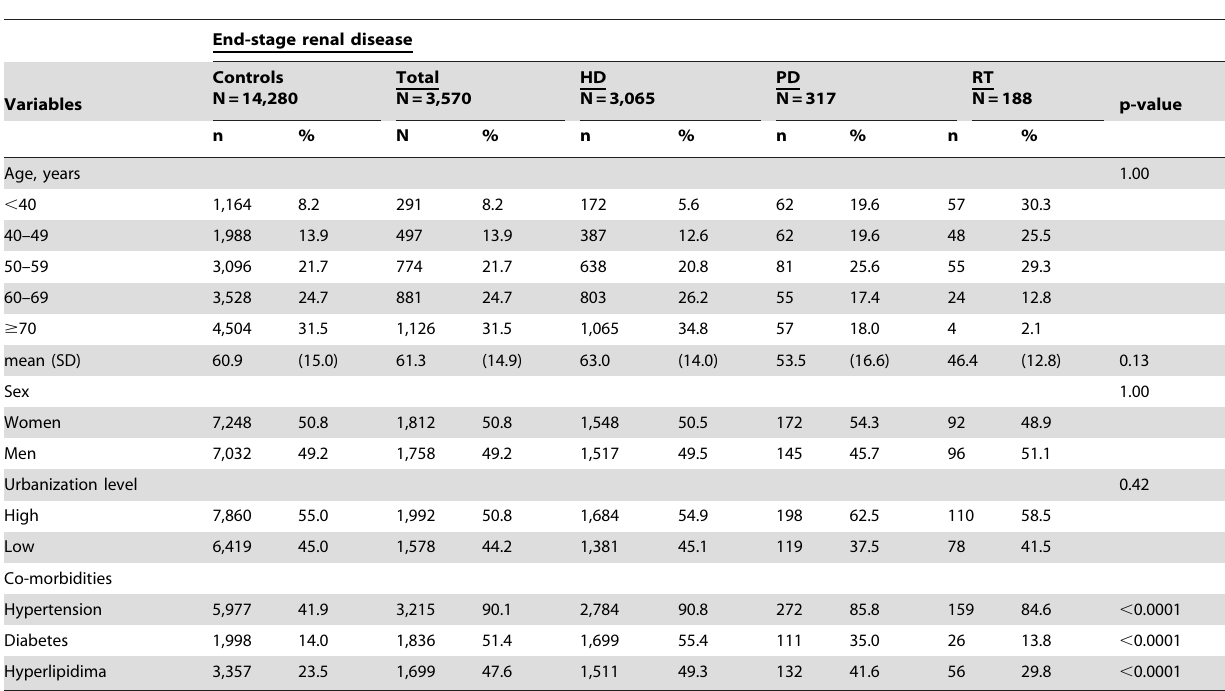
Table 1. Demographic characteristics and co-morbidities of patients with end-stage renal disease by treatment status.